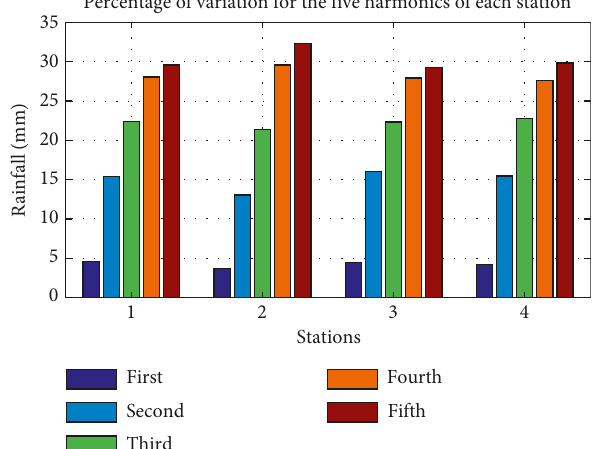
Figure 4: Percentage of variance for all stations ( x -axis: 1 � Bahir Dar, 2 � Dangila, 3 � Debre Tabor, and 4 �